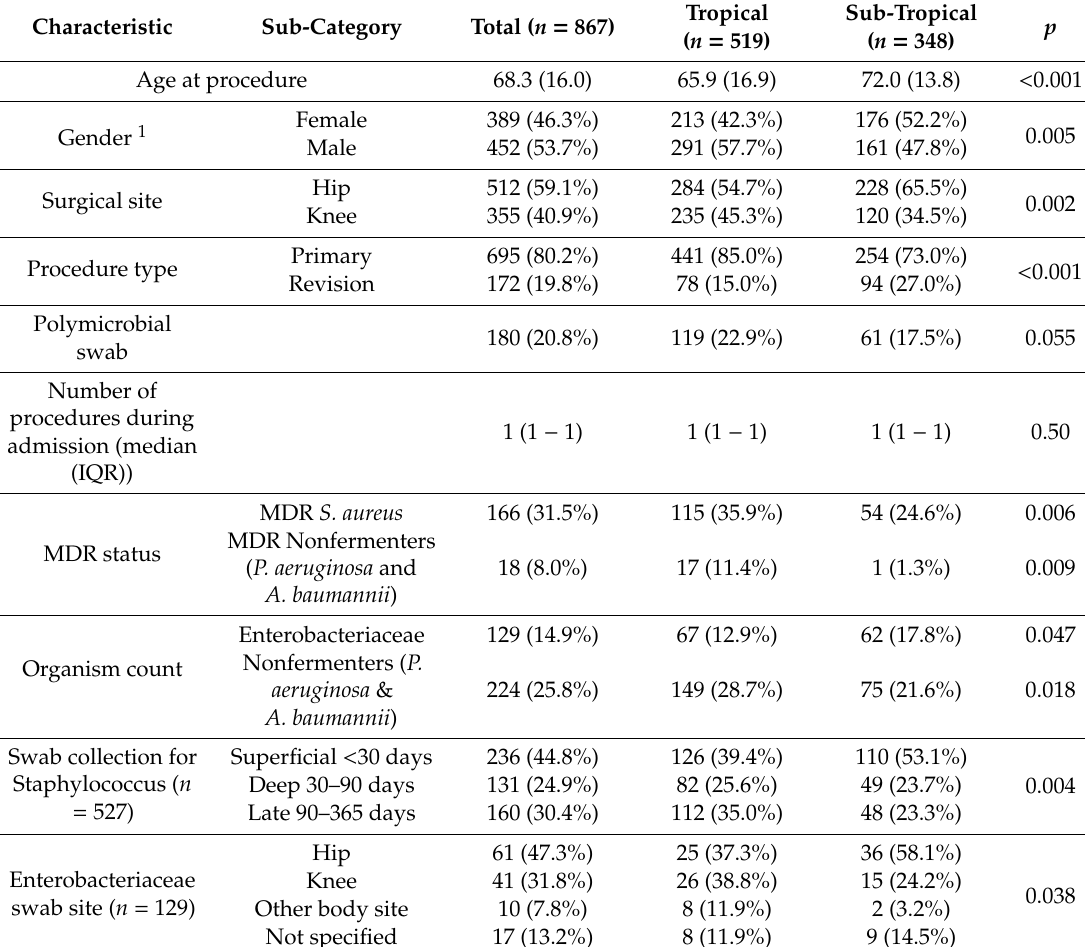
Table 1. Di ff erences between tropical versus subtropical hospitals for patient characteristics and bacteria cultured in the 12 months following lower limb orthopaedic